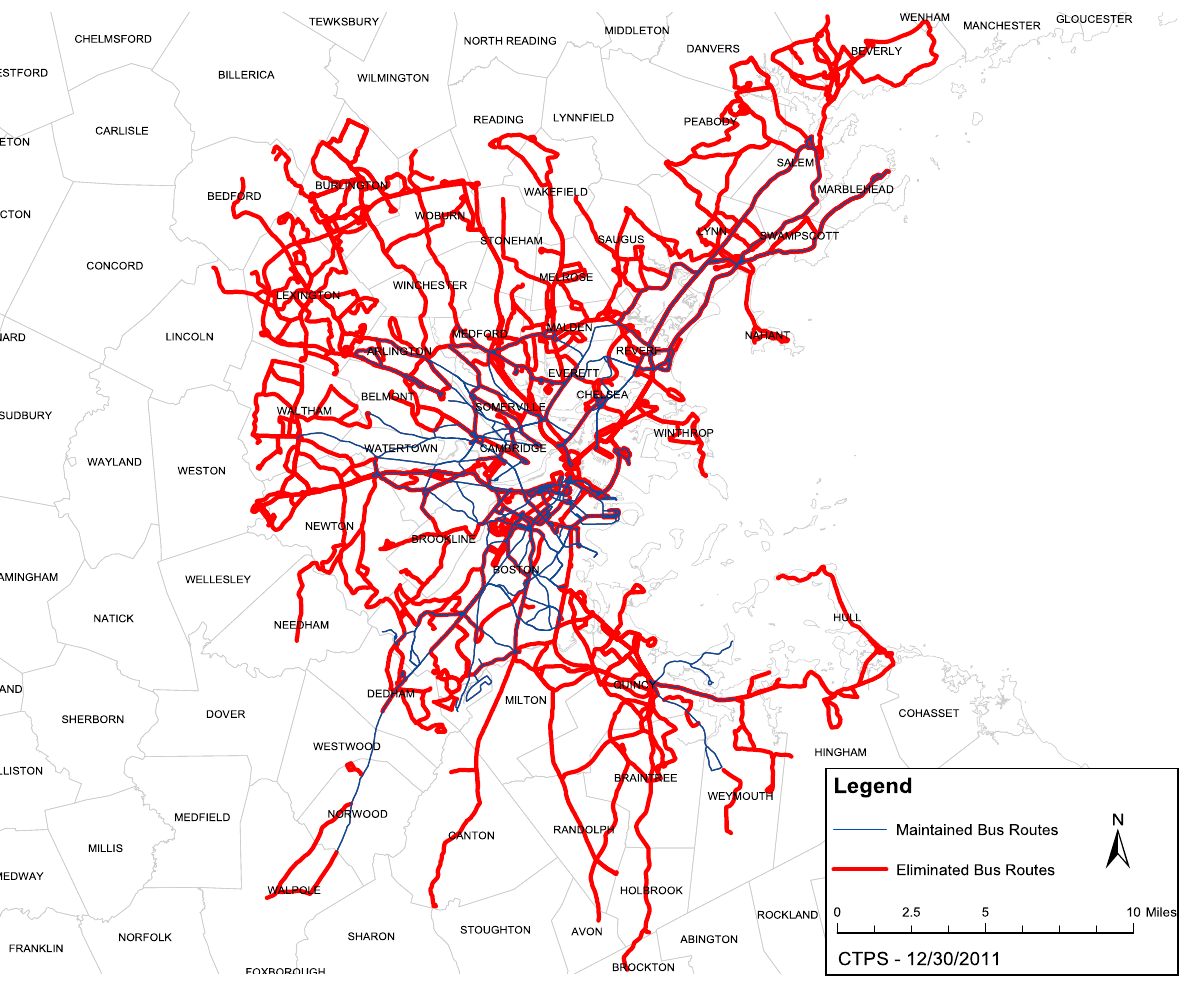
Figure 1. Eliminated bus routes under Scenario 2 (Image from CTPS 2011